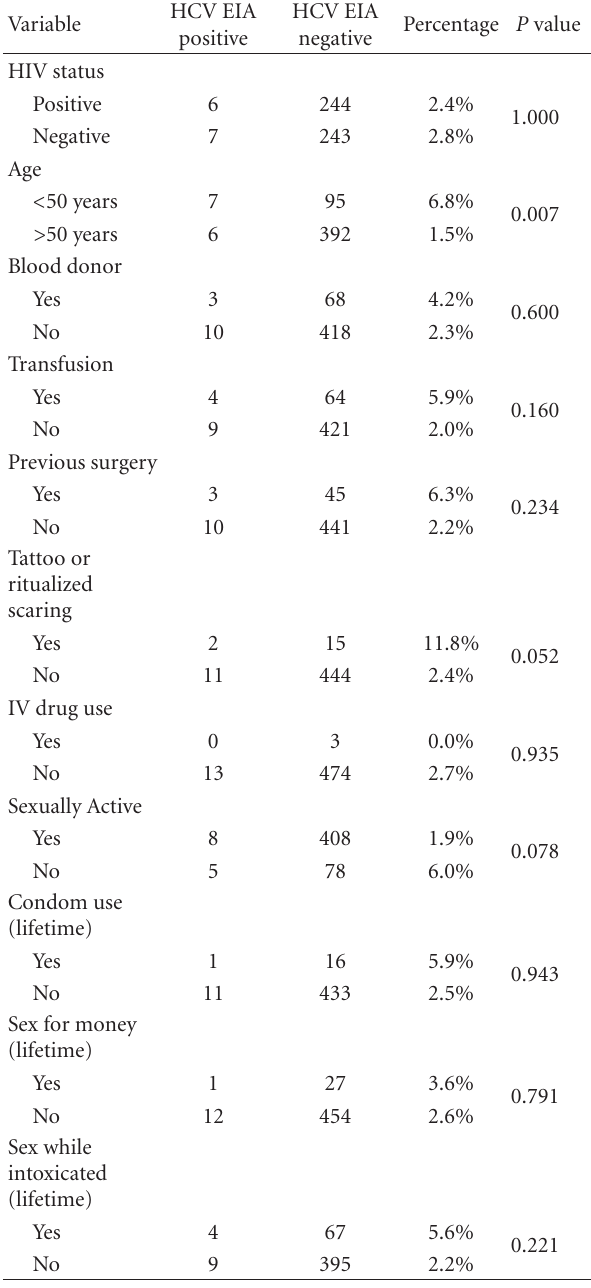
Table 2: Risk factor analysis of study